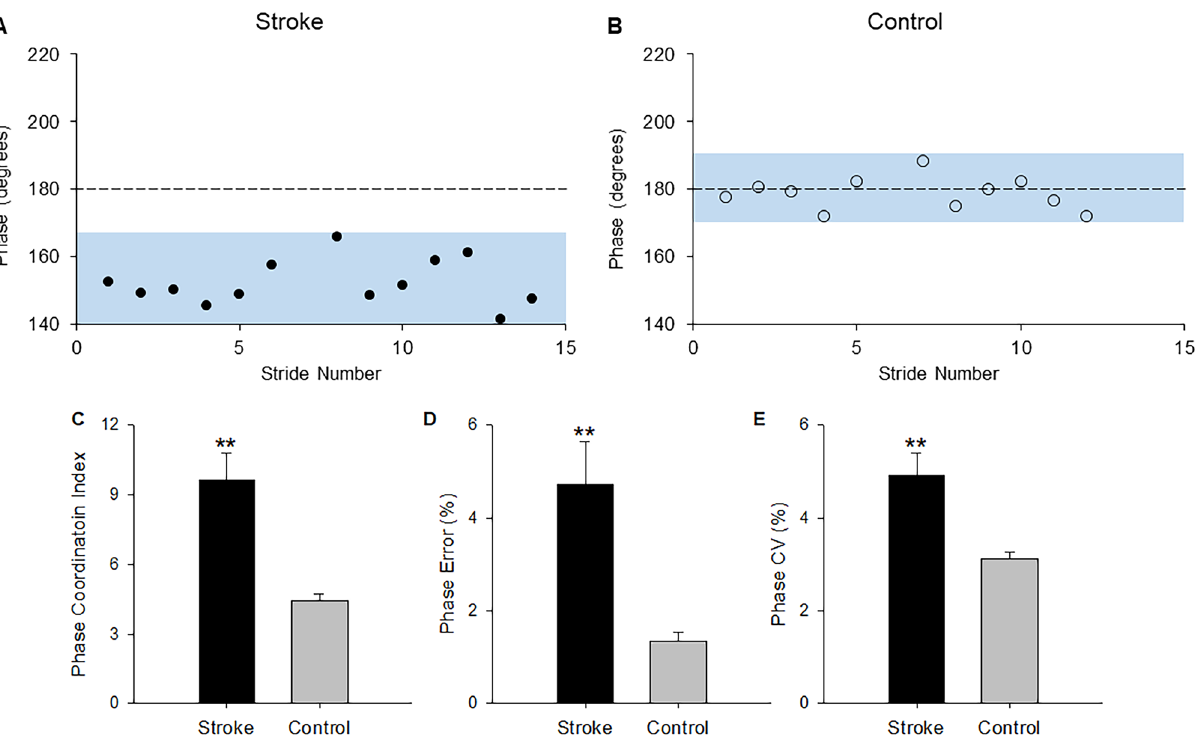
Figure 2. The impact of stroke on bilateral gait coordination: the phase values from a representative walking trial of ( A ) a stroke participant and ( B ) a control participant. The dashed line represents the ideal phase of 180° during walking. The shaded region represents the variability in phase values across the strides. The individual with stroke showed greater deviation of the phase from the 180° and higher variability of phase across consecutive strides relative to the control. Compared with the control group, the stroke group showed significantly increased ( C ) phase coordination index, ( D ) phase error relative to the ideal phase of 180°, and ( E ) coefficient of variation (CV) of phase during overground walking. ** p <